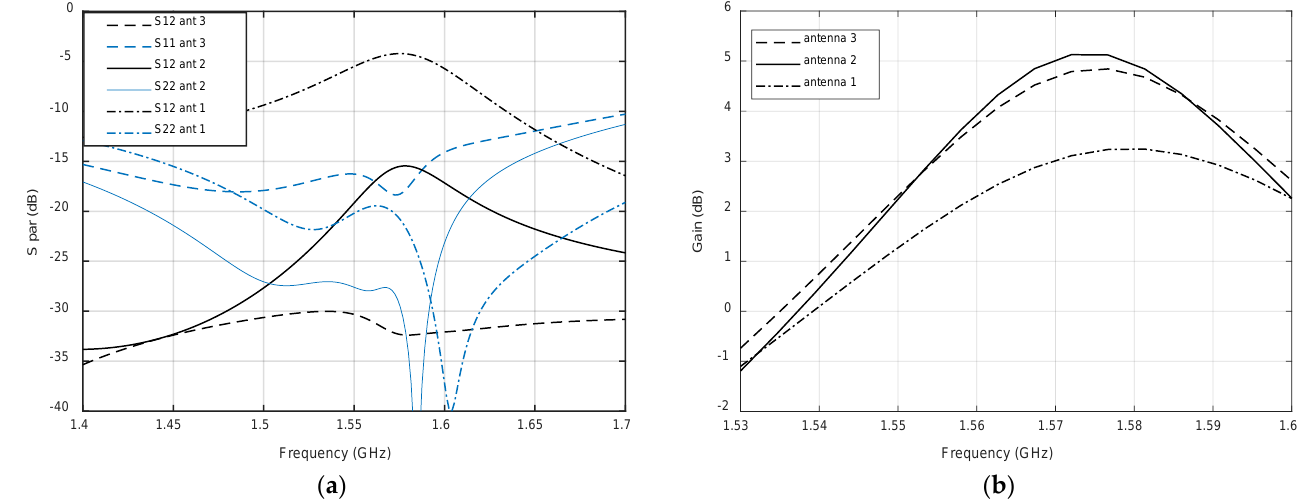
Figure 5. Simulated results for the three proposed antennas in the GPS band: ( a ) scattering parameters; ( b ) gain.